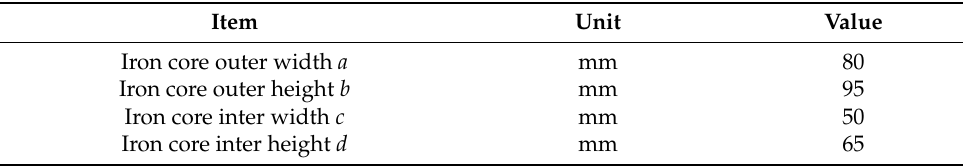
Table 1. Structure parameters of shell-type nanocrystalline iron